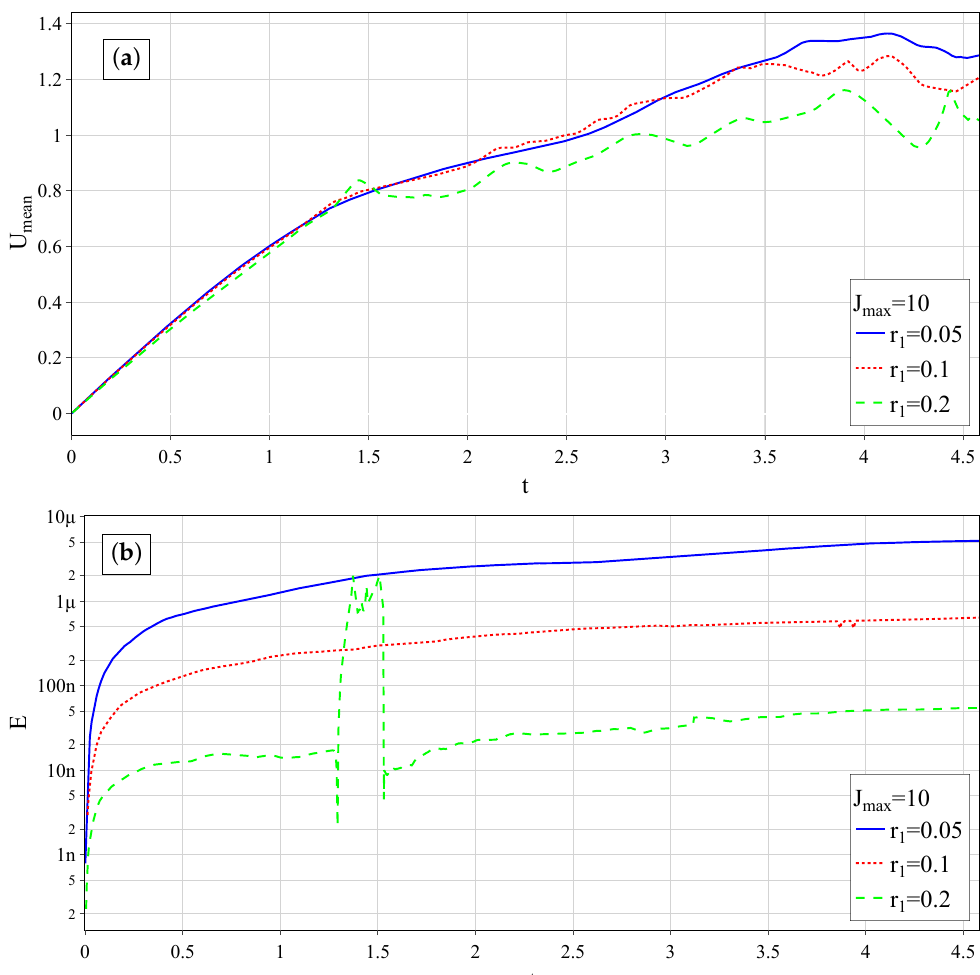
Figure 10. ( a ) The mean flow velocity in the domain, U mean , as a function of time for the bubble passing between two obstacles. ( b ) The relative error E = mass) as a function of time, where V g is the current gas volume, and V g ,0 is the initial gas volume. Both graphs are shown for the bubble radii r 1 = 0.05,0.1, and 0.2. The maximum level of refinement is J max =